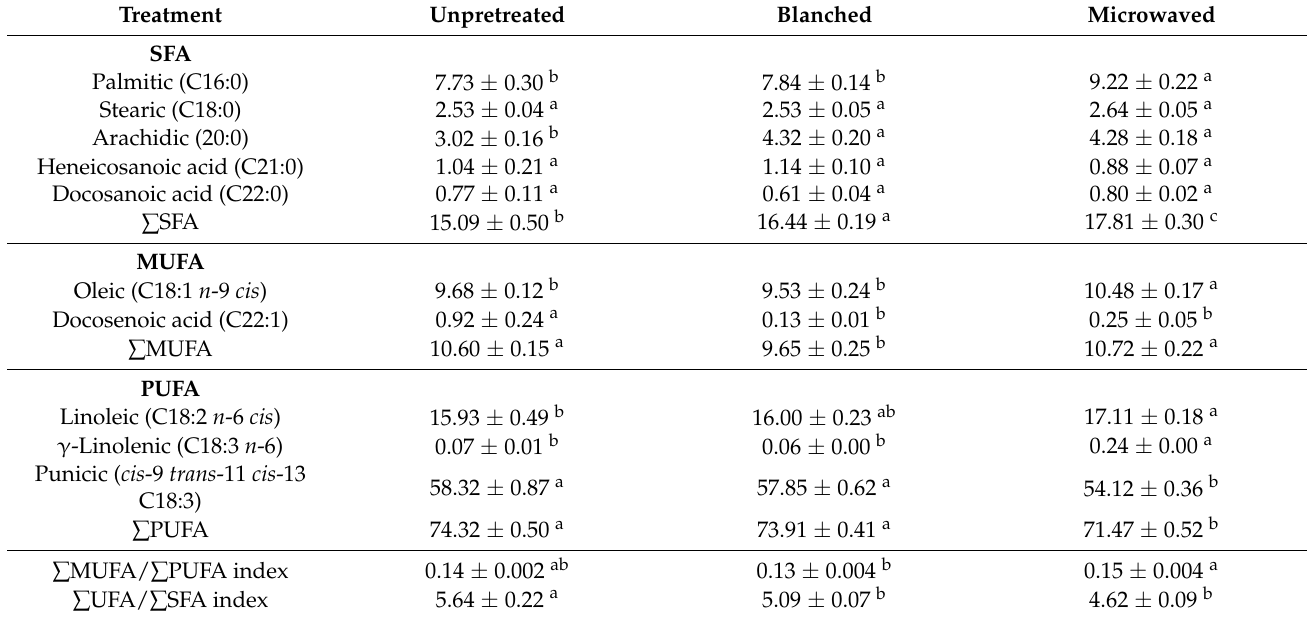
Table 2. Fatty acid composition of cold-pressed pomegranate seed oil from unpretreated, blanched (95 ± 2 ◦ C/3 min), and microwave-heated (261 W/102 s)